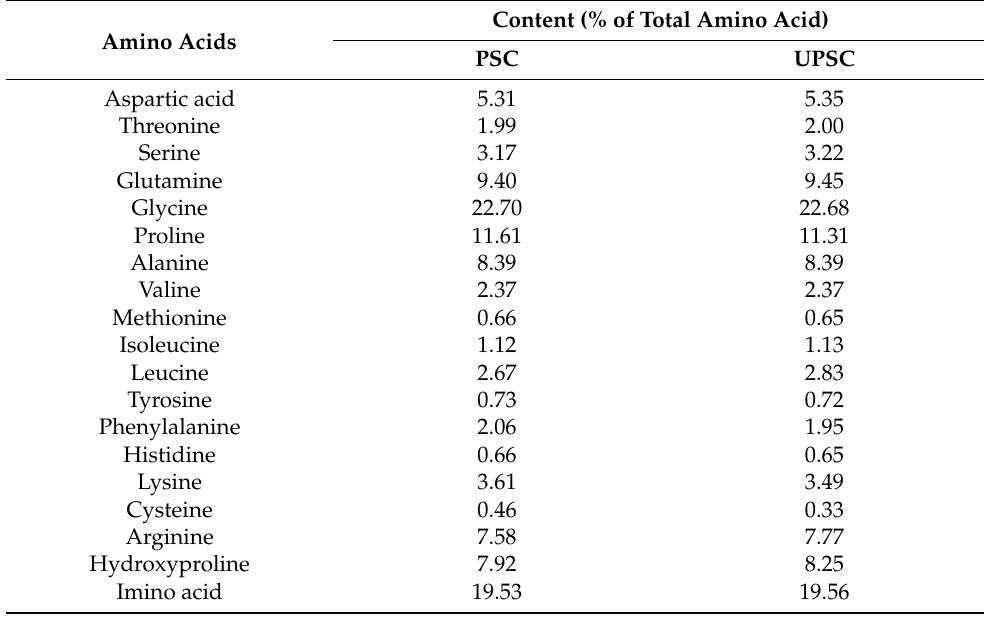
Table 1. Bactrian camel skin PSC and UPSC amino acid compositions. Amino